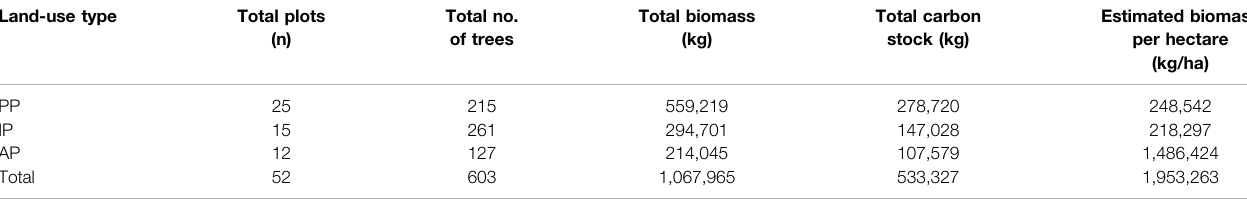
TABLE 5 | Total amount of biomass and above-ground carbon in the selected land-use types. Land-use type